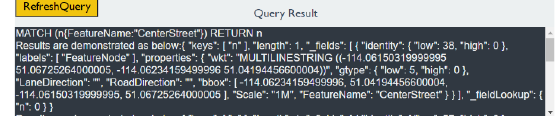
Figure 15 . Result of Free